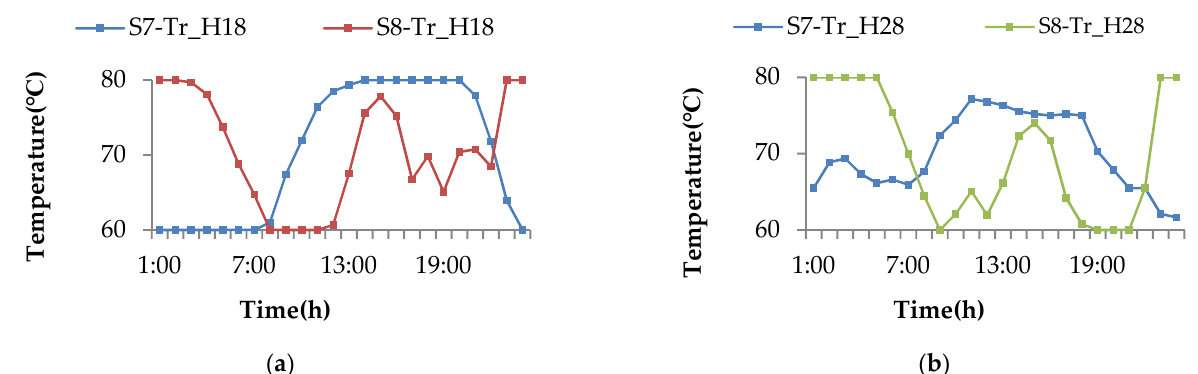
Figure 12. Before DTES is configured, the return temperature before and after the heat load curve changes: ( a ) H18 node and ( b ) H28 node.